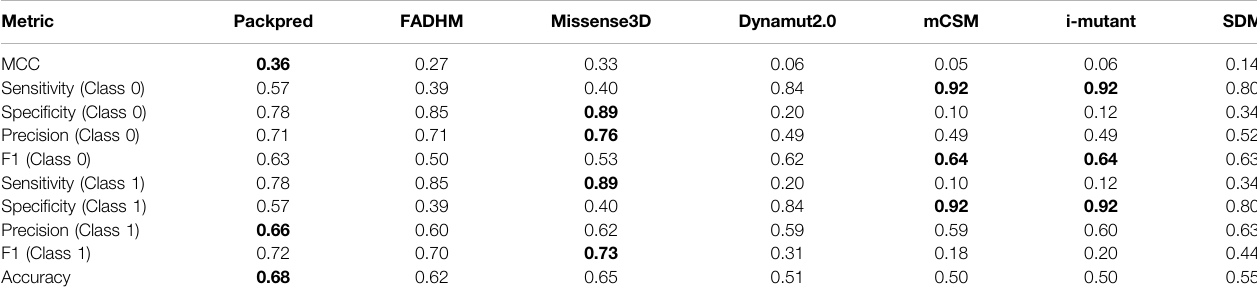
TABLE2| PredictionperformanceofsevenmethodsontheMissense3Ddataset.Thebestscoreineachassessmentmetricisshowninboldfont.ValuesofClass1areused to describe the results in the manuscript. Metric Packpred FADHM Missense3D Dynamut2.0